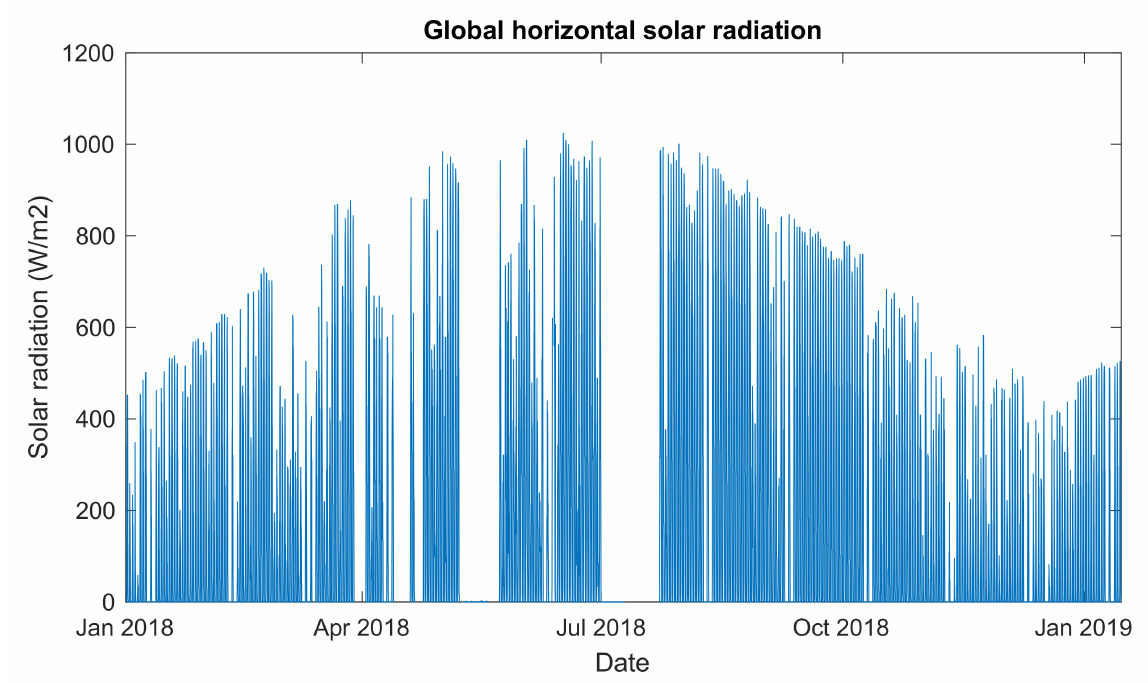
Figure A1. Global horizontal solar